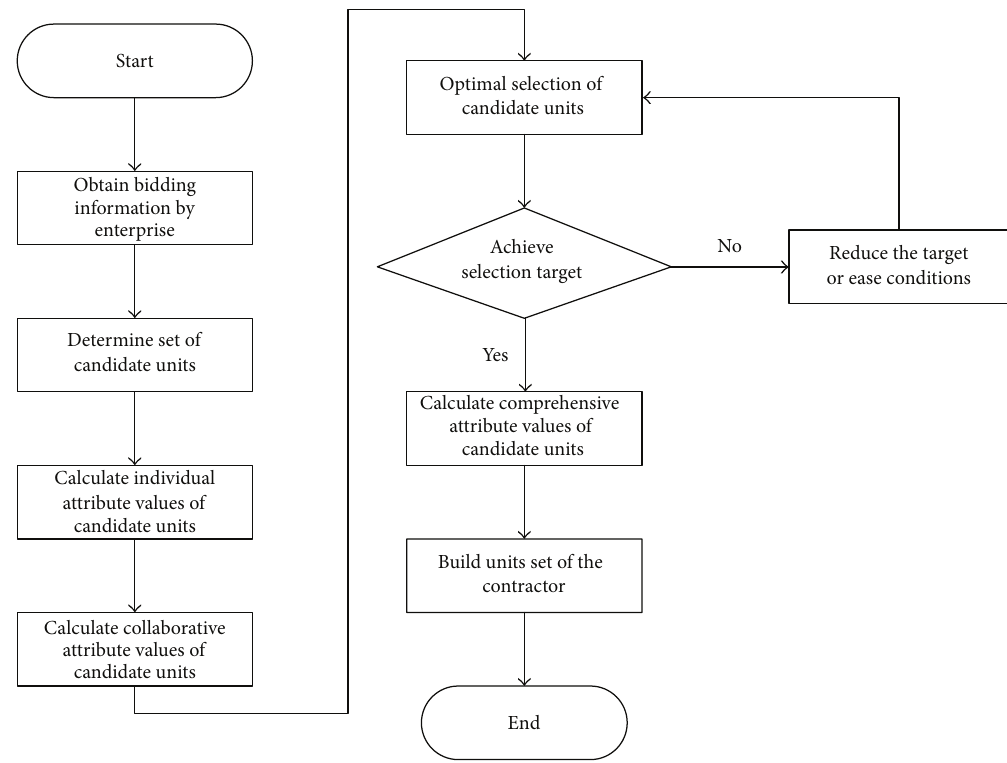
Figure 3: Building process for choosing units of the